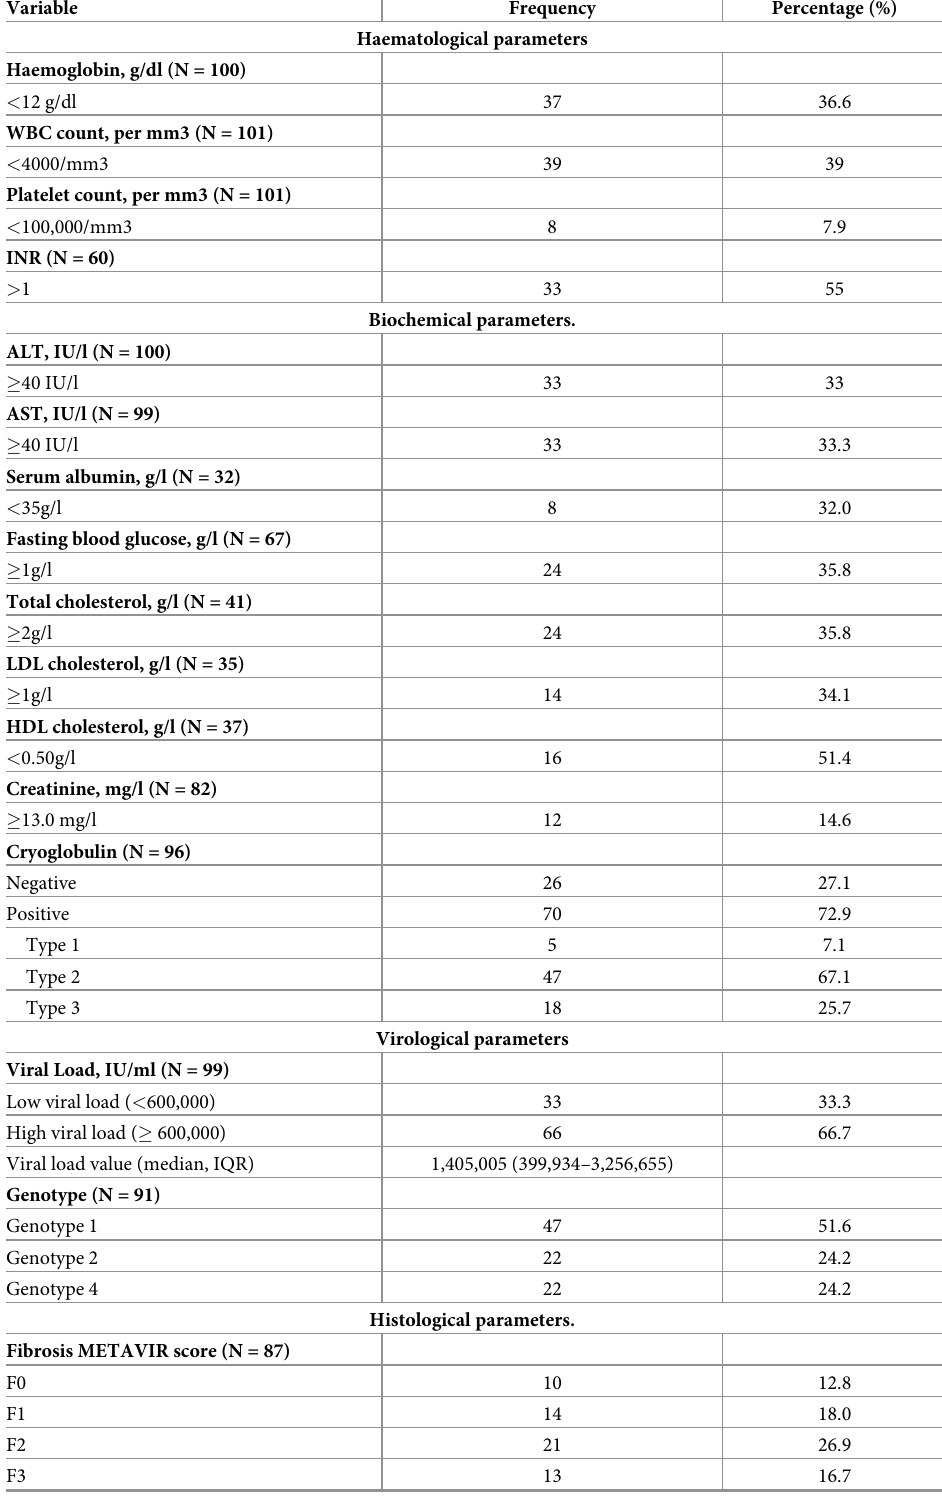
Table 3. Laboratory characteristics of study